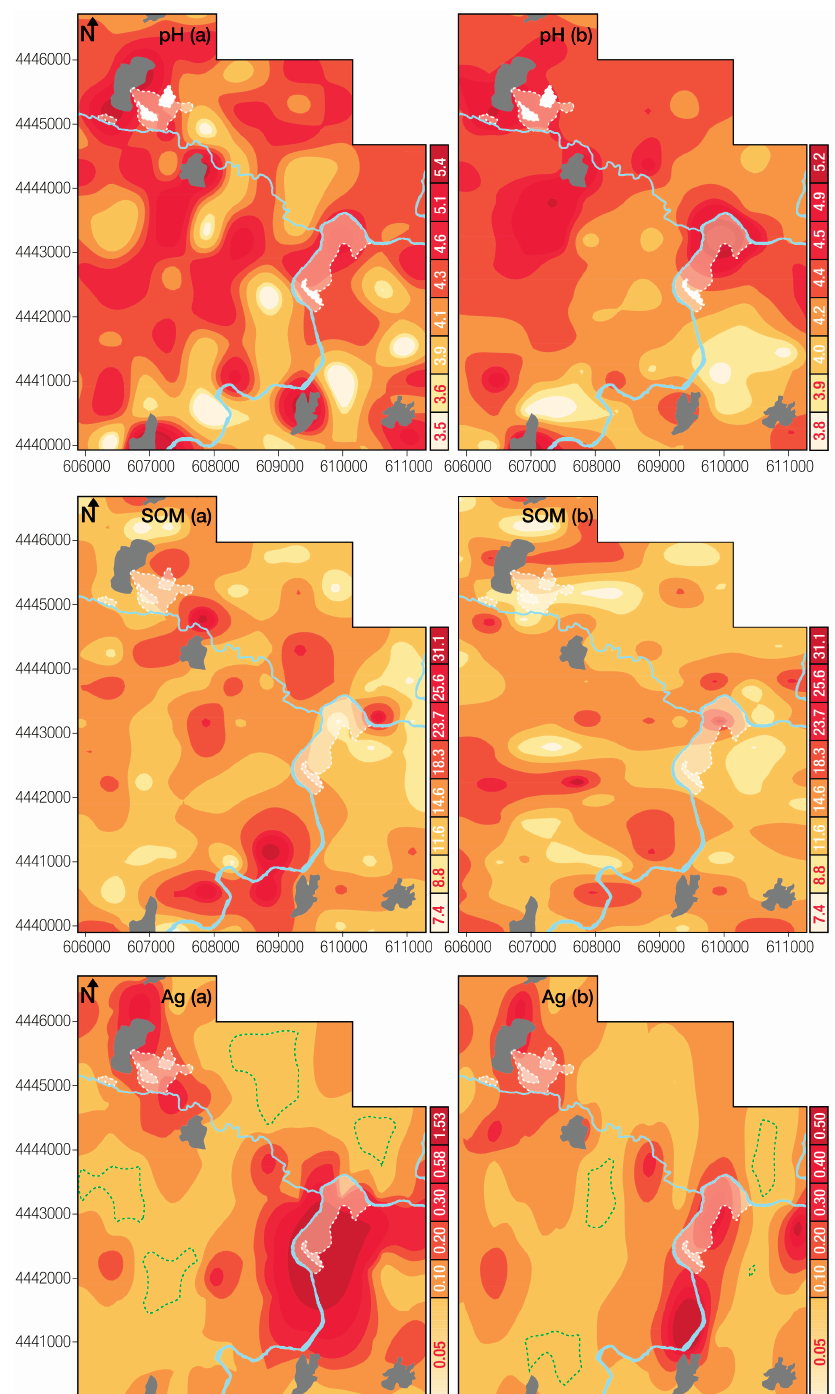
Figure 2. Spatial distribution of pH and soil organic matter (SOM, %) and Ag (mg kg − 1 ) for topsoil ( a ) and subsoil ( b ). Percentile class limits at P5, P10, P25, P50, P75, P90, P95 and P97.5. In blue are represented the main water courses, in grey the villages and in white the main tailings and dams. The green dashed lines represent the Ag background